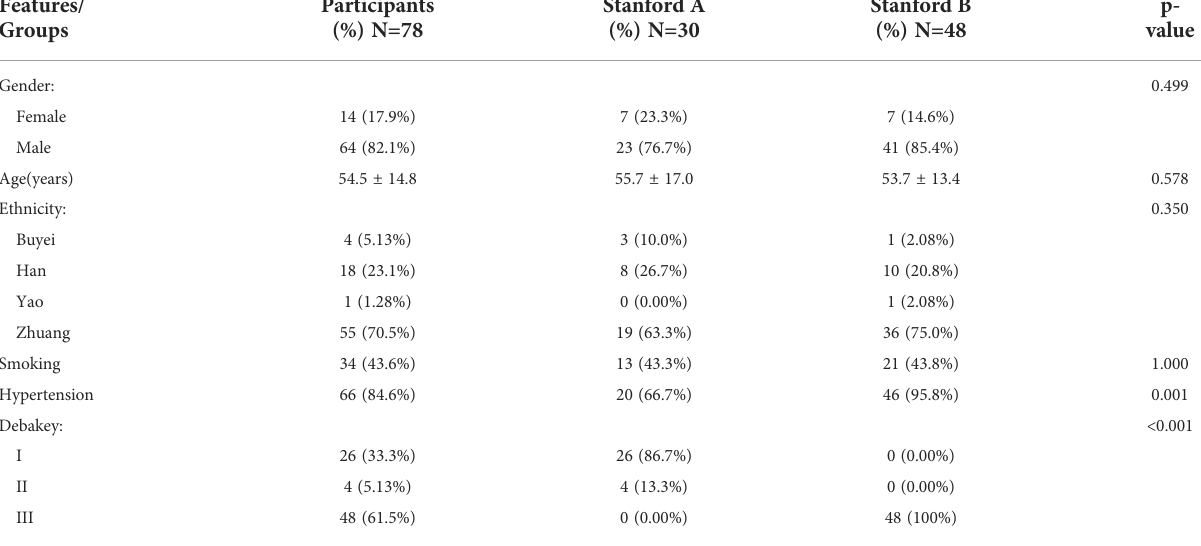
TABLE 2 Baseline characteristics table of AD based on the Stanford classi fi